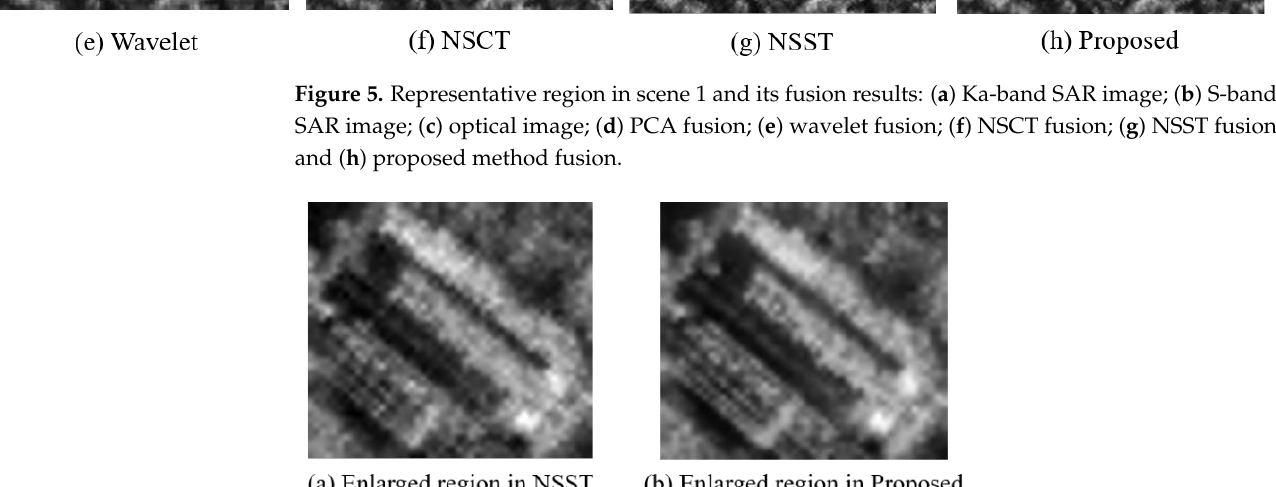
Figure 7. Representative region in scene 2 and its fusion results: ( a ) Ka-band SAR image; ( b ) S-band SAR image; ( c ) optical image; ( d ) PCA fusion; ( e ) wavelet fusion; ( f ) NSCT fusion; ( g ) NSST fusion; and ( h ) proposed method fusion. Figure 8. Enlarged marked region in scene 2: ( a ) Enlarged marked region in the NSST fusion and ( b ) enlarged marked region in the proposed method fusion. 3.2. Comparison of Colorization Results Although the fusion methods compress the information of the SAR images, it is dif- ficult to distinguish different regions from the grayscale map. To facilitate the use of the fusion image, we extract the band and polarization difference information from the SAR